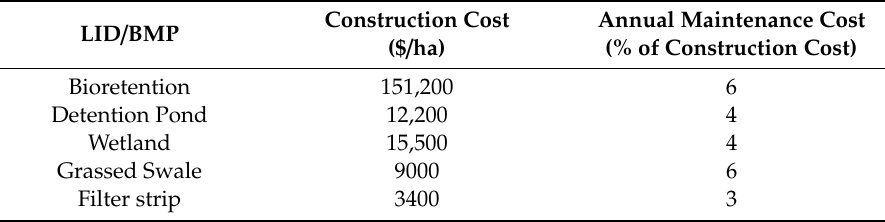
Table 4. Construction costs and annual maintenance costs of LID / BMPs [45–49] (Brown and Schueler